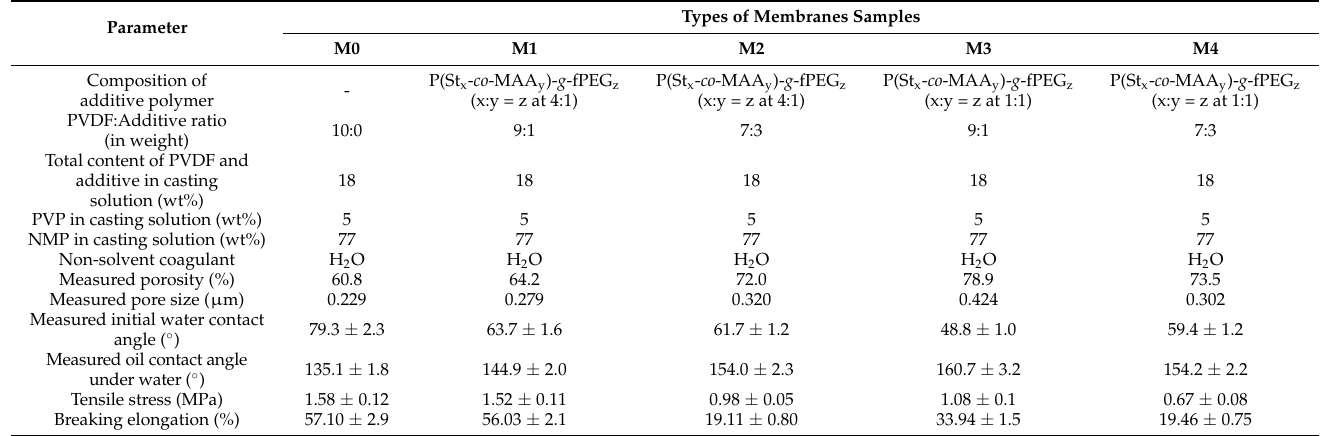
Table 1. The compositions and some properties of the prepared